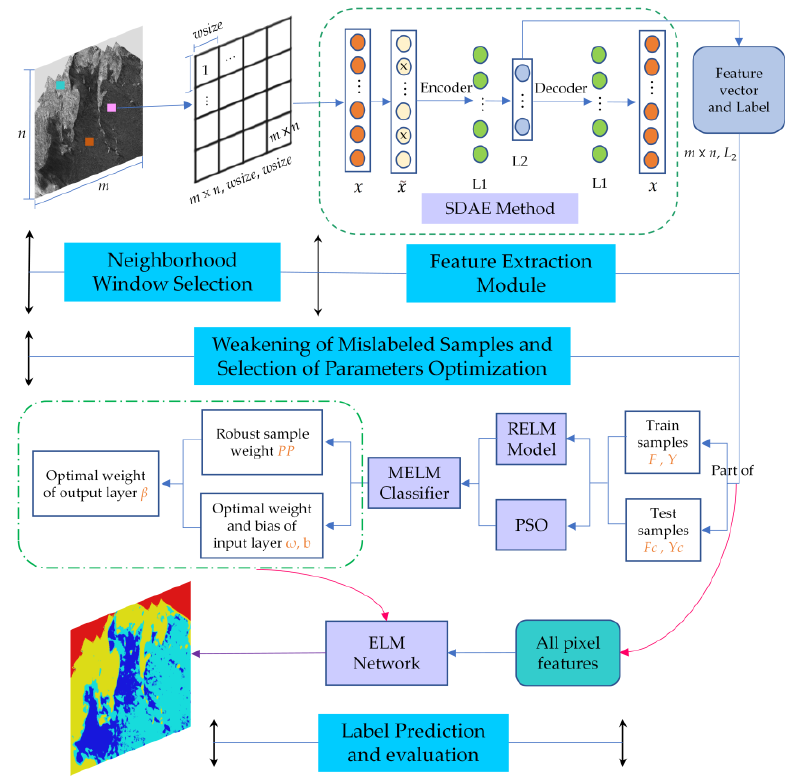
Figure 1. Flowchart of sediment classification based on the acoustic backscatter image.